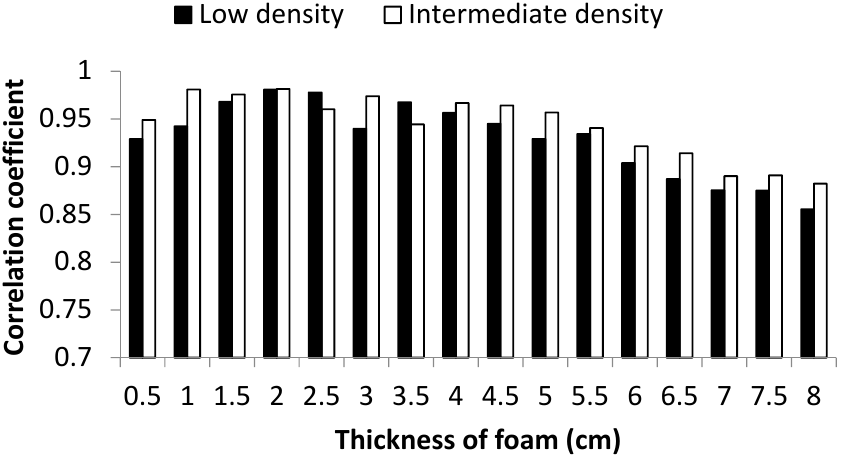
Figure 5. Comparison of Pearson’s correlation coefficients between DCTM and NCTM in relation to thickness of the cushion and the foam density.